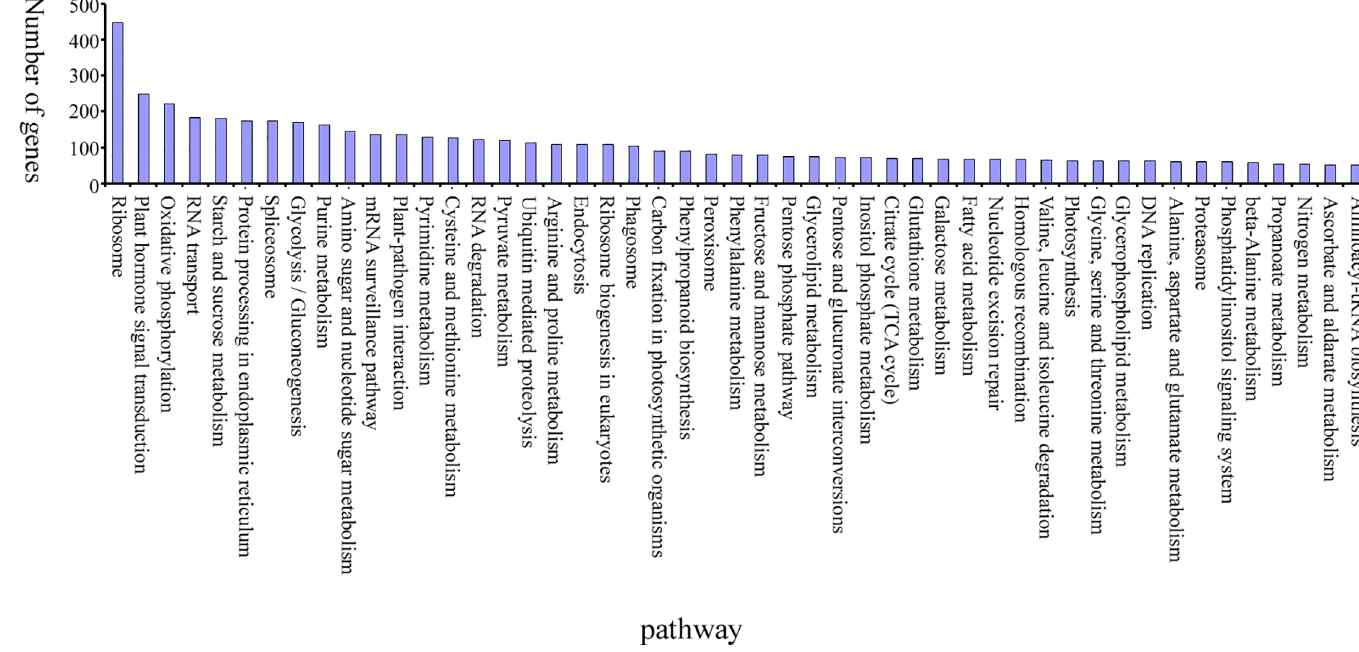
Fig 5. Distribution of pathway based on the KEGG database.